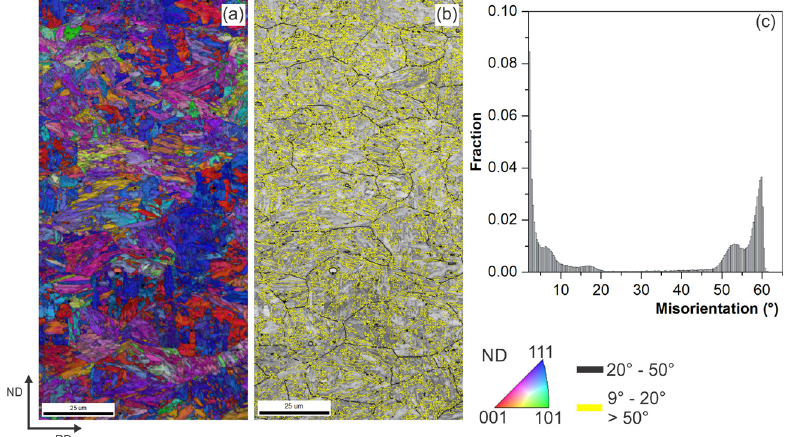
Figure 2. Sample after air-quenching treatment: (a) inverse pole figure (IPF) map and (b) grain boundary map superimpose the corresponding image quality map and (c) misorientation angle distribution.